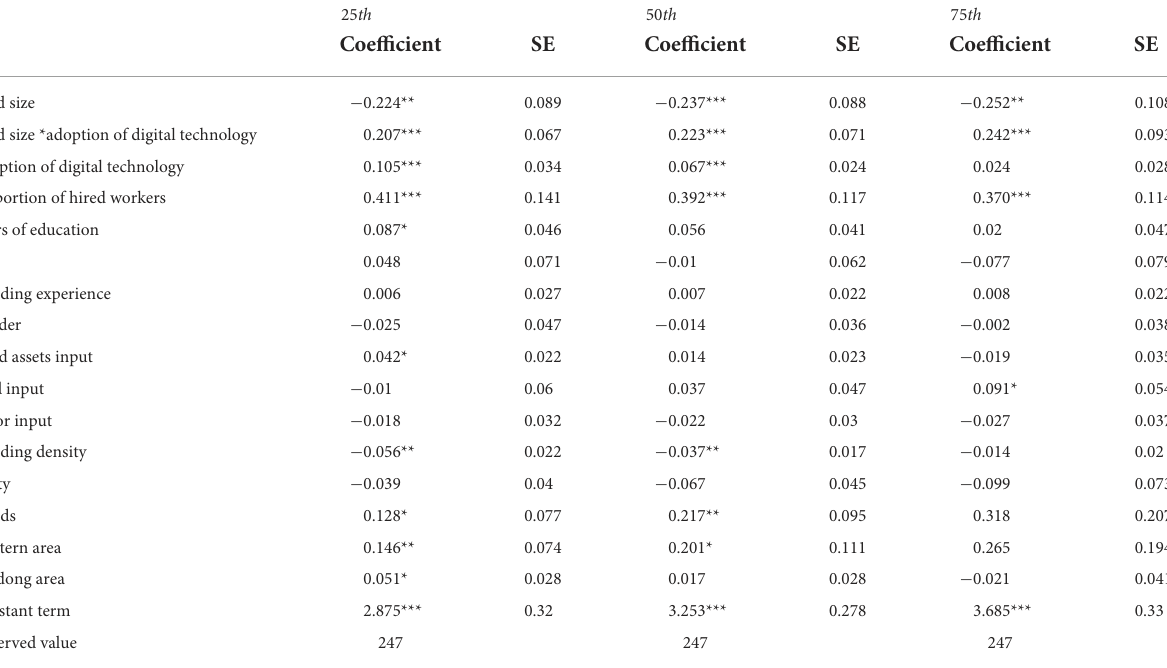
TABLE 8 Robustness test: Influence of digital technology adoption on the relationship between herd size and dairy cow yield at different